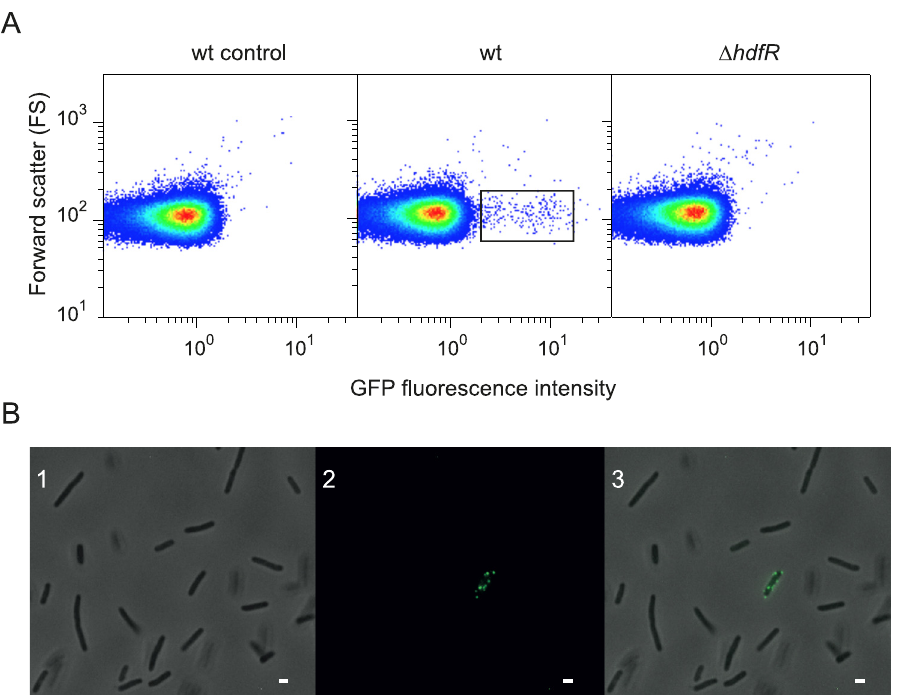
Fig 1. Bistable expression of the std operon. A. Single cell analysis of GFP fluorescence intensity by flow cytometry in a strain carrying an stdA :: gfp fusion in different genetic backgrounds (wt and Δ hdfR ). On the left, a negative control is shown ( S . enterica cells without gfp fusion). B. Detection of Std fimbriae by immunofluorescence microscopy. Panel 1 shows a phase-contrast image of S . enterica cells. Panel 2 shows detection of Std fimbriae with anti-StdA antiserum and goat anti-rabbit antibody conjugated to FITC (green signal). In panel 3, both channels are merged. Scale bar: 1 μ m.